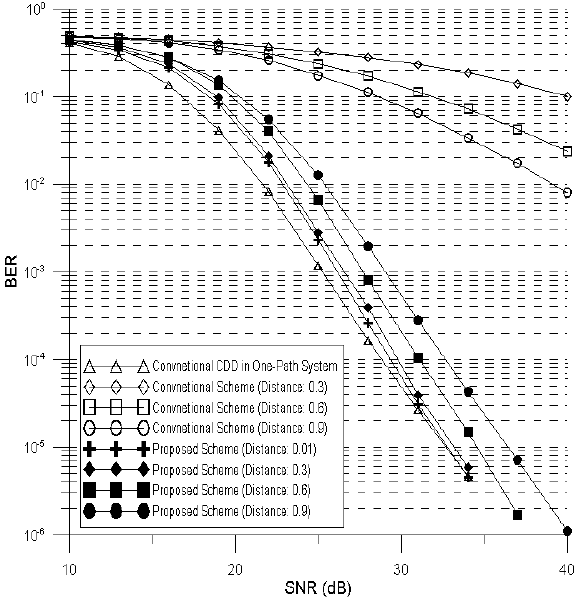
Figure 4. The BER performances for the conventional FIC and the proposed scheme.